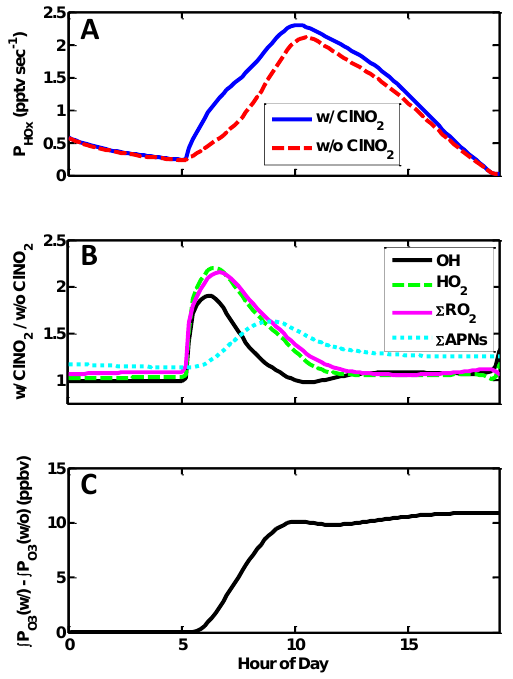
Fig. 5. (A) The HO x production rate with ClNO 2 formation (solid blue line) and without ClNO 2 formation (dashed red line). (B) The ratio of the hydroxyl radical (solid black line), hydroperoxyl radi- cal (dashed green line), sum of organic peroxy radicals (solid pink line), and sum of acyl peroxy nitrates (dotted cyan line) for the with- ClNO 2 case relative to the without-ClNO 2 case. (C) The difference between the integrated ozone production rate with ClNO 2 formation and the integrated ozone production rate without ClNO 2